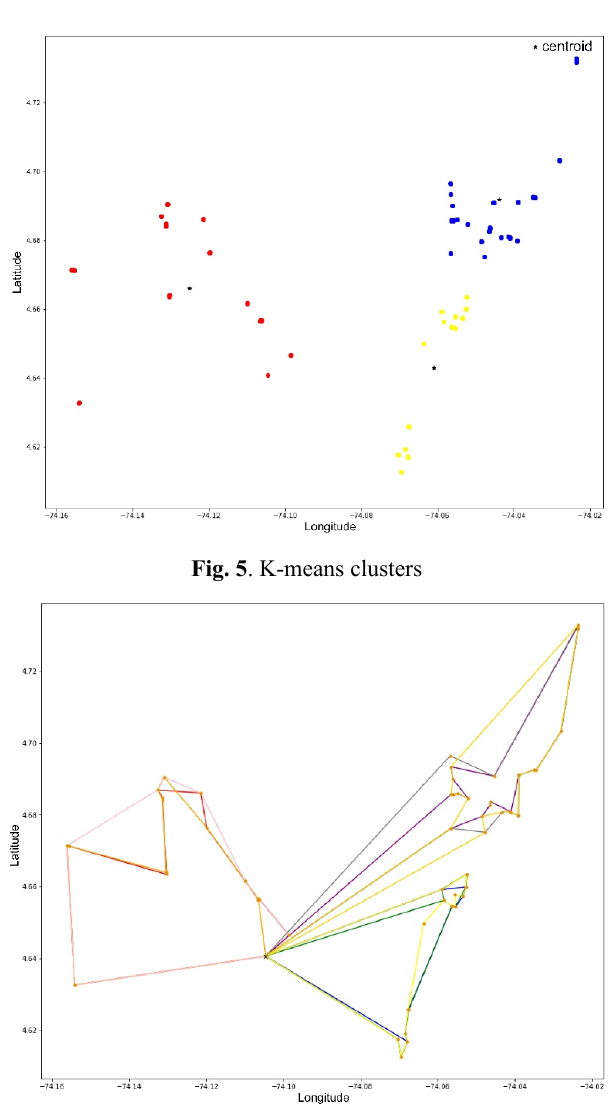
Fig. 6 . Routes generated for 205